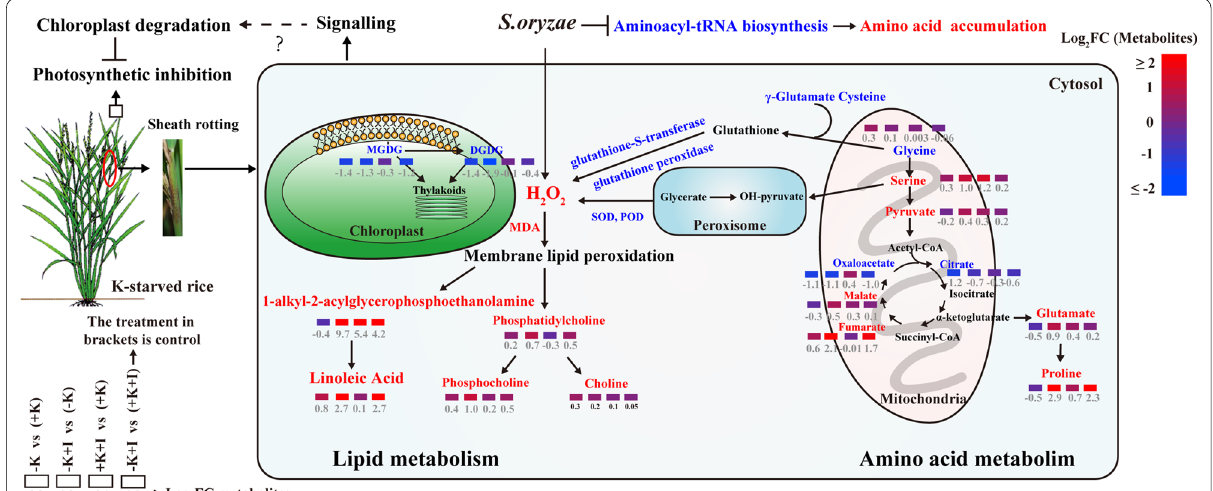
Fig. 7 Summary model of the metabolic processes underlying the response of K-starved rice to S. oryzae infection. First, S. oryzae invades rice from FLSs and causes H 2 O 2 accumulation, which results in severe oxidative stress. However, MGDG and DGDG contents, which are essential for maintaining membrane integrity and stability, were profoundly decreased in the K-starved FLSs. Likewise, K deficiency also decreases the synthesis of the antioxidant glutathione and the activities of SOD and POD. The consistent accumulation of H 2 O 2 in K-starved rice induces lipid peroxidation, which accelerates 1-alkyl-2-acylglycerophosphoethanolamine and linoleic acid accumulation in K-starved FLSs. Second, S. oryzae infection impacts the biosynthesis of aminoacyl-tRNA, which results in amino acid accumulation in FLSs. Proline is upregulated and citrate is downregulated in K-starved rice, implying that energy metabolism and osmotic balance are disrupted by S. oryzae infection. As a systematic response, S. oryzae infection also induces the degradation of chloroplasts in flag leaves, which down regulates the photosynthetic rate of K-starved rice. Overall, alterations in these series of metabolic processes in K-starved rice promote S. oryzae development and sheath rotting. Note: FC in metabolite abundance for the treatments versus controls was calculated. The log 2 (FC) is indicated by the shade of red or blue according to the color scale, and the numbers below the rectangle indicate the corresponding log 2 (FC) values. The metabolites or physiological parameters in red/blue represent up/down regulation in K I-treated plants versus K I-treated plants. The symbol “?” means that the mechanism is not yet − + + +